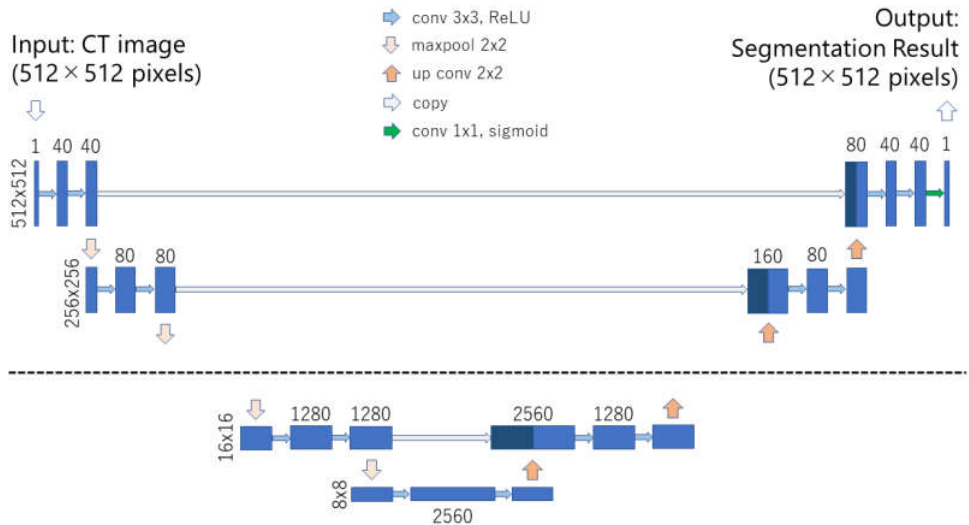
Figure 1. Illustration of the deep U-net model. The number of downsampling and upsampling is 6 in the deep U-net. Except for the last convolution layer, dropout and convolution layer are coupled. Abbreviations: convolution layer (conv), maxpooling layer (maxpool), upsampling and convolution layer (up conv), rectified linear unit (ReLU).